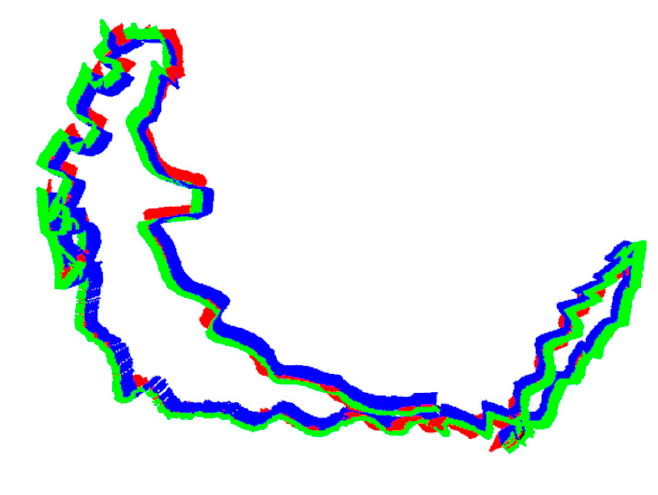
Figure 4. Camera trajectory.